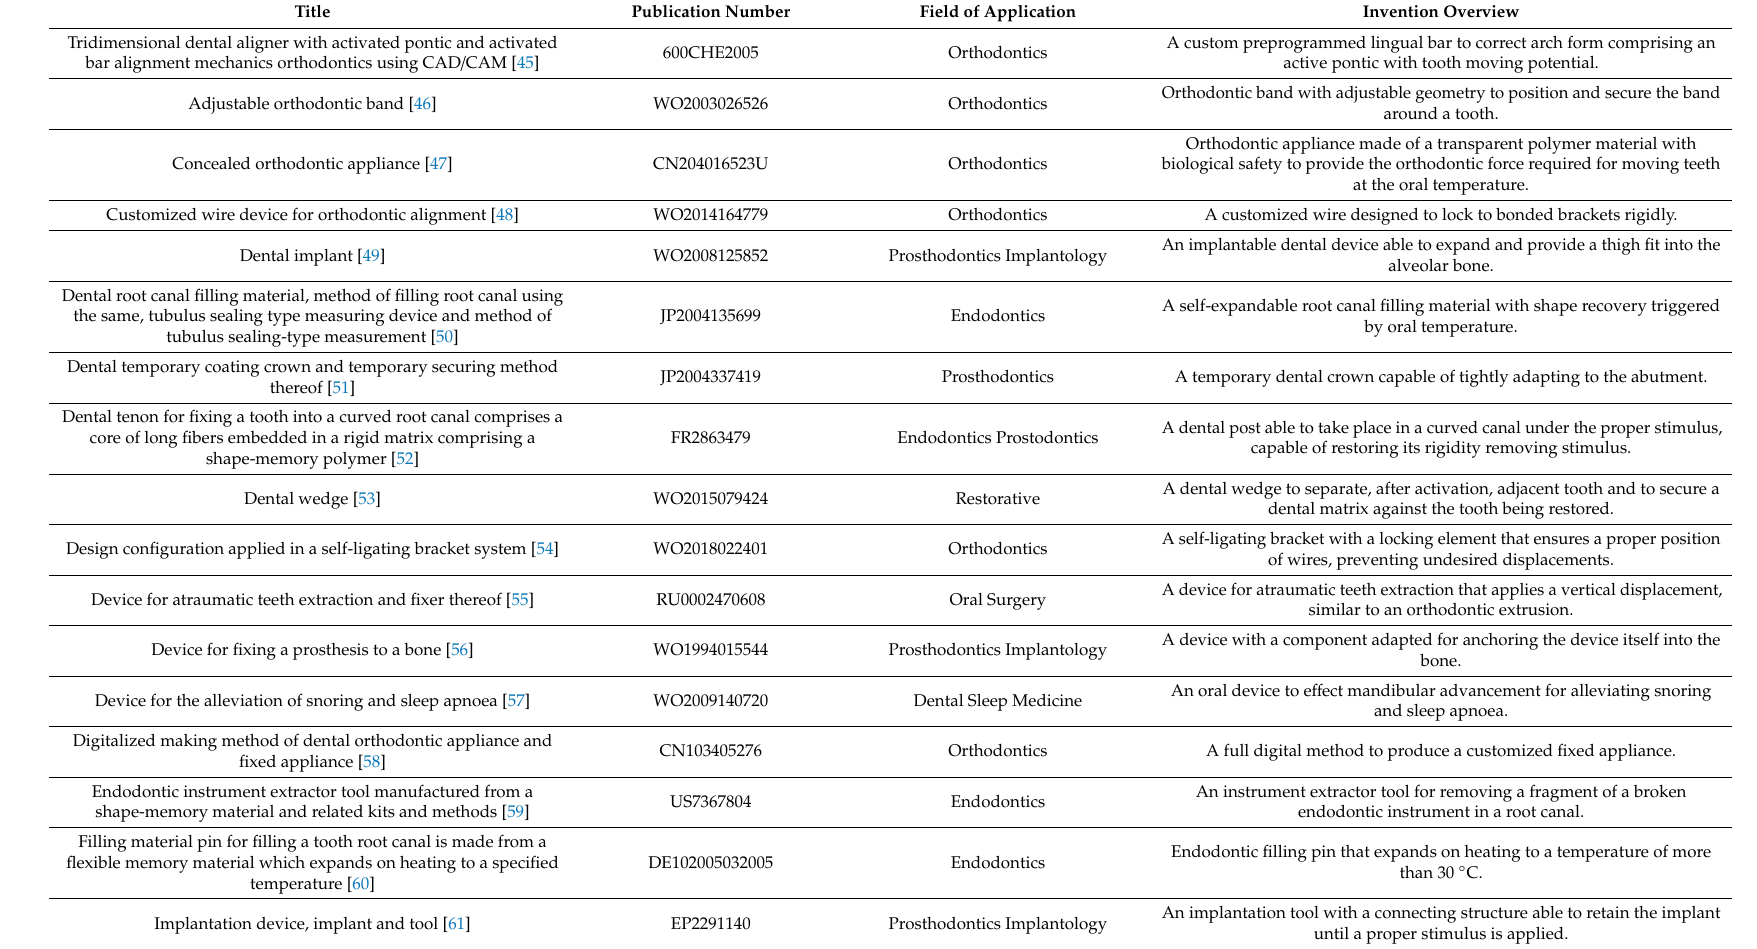
Table 8. Patents included in the patent landscape